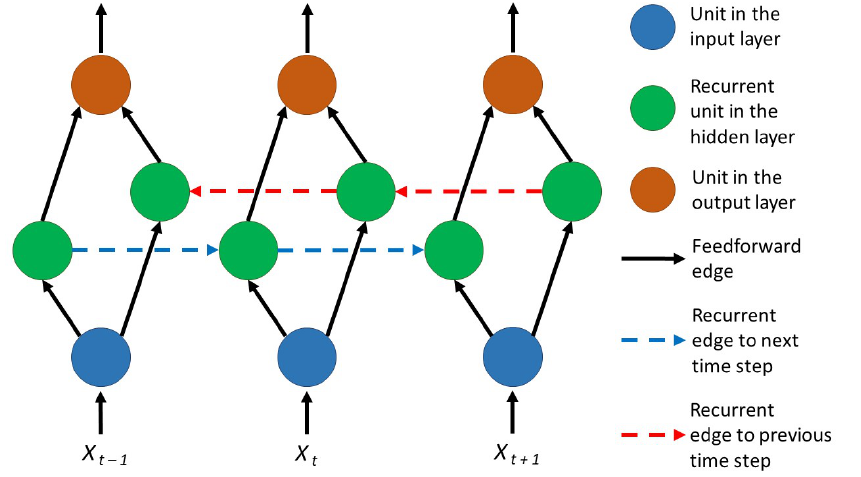
Figure 5. Bidirectional recurrent neural